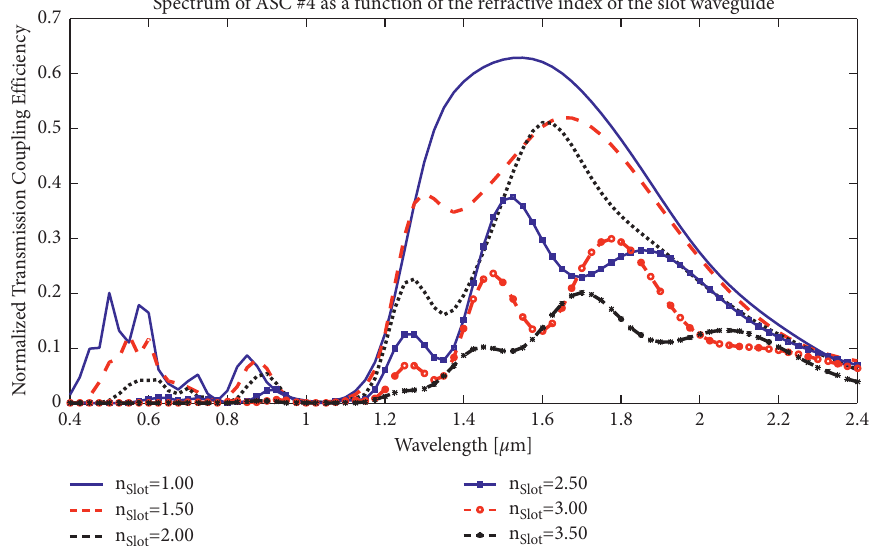
Figure 4: The spectrum of ASC #4 for different refractive indices of the slot waveguide, n